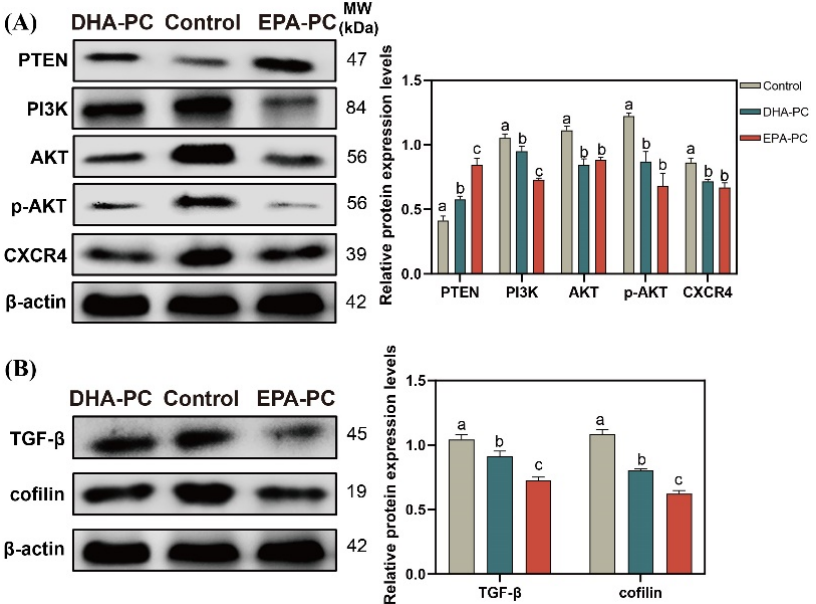
Figure 7. DHA-PC and EPA-PC downregulated the protein level of key transcription factors of the migration. ( A ) the expression of PTEN, PI3K, AKT, p-AKT, and CXCR4. ( B ) the expression of TGF- β and cofilin. Different letters (a, b, and c) indicate remarkable differences at p < 0.05 among all groups determined by ANOVA (Bonferroni’s test).